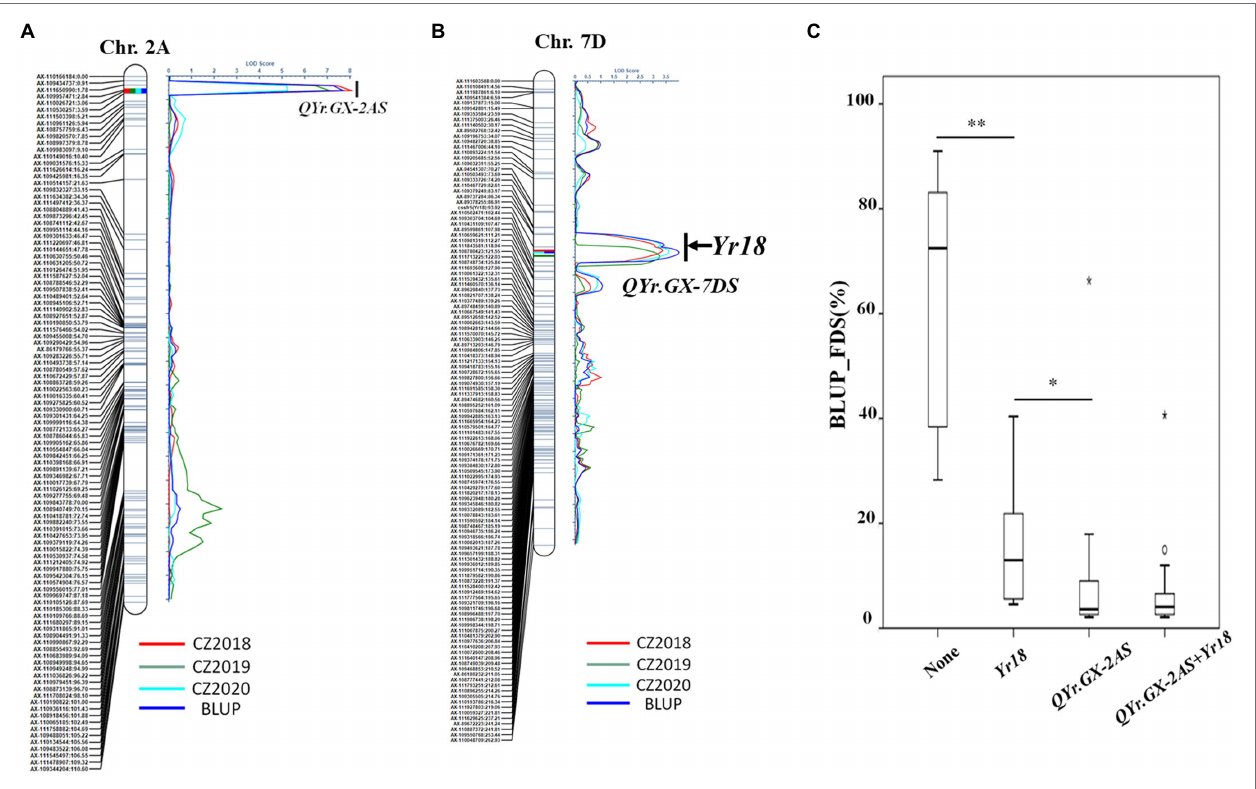
FIGURE 3 | QTL conferring adult plant stripe rust resistance detected by inclusive composite interval mapping (ICIM) in the recombinant inbred lines (RILs) population from Gaoxianguangtoumai (GX) × Taichung 29 (TC 29). Graphical displays of QTL (A) QYr.GX-2AS and (B) QYr.GX-7DS detected on chromosome 2A and 7D based on the final disease severity (FDS) from three field trials and best linear unbiased prediction (BLUP) data. The box plots for final disease severity (FDS) based on the best linear unbiased prediction (BLUP) data associated with the two loci ( QYr.GX-2AS and Yr18) and their combination in the Gaoxianguangtoumai (GX) × Taichung 29 (TC 29) recombinant inbred lines (RILs) population (C) . *indicate significant at P = 0.05; **indicate significant at P =